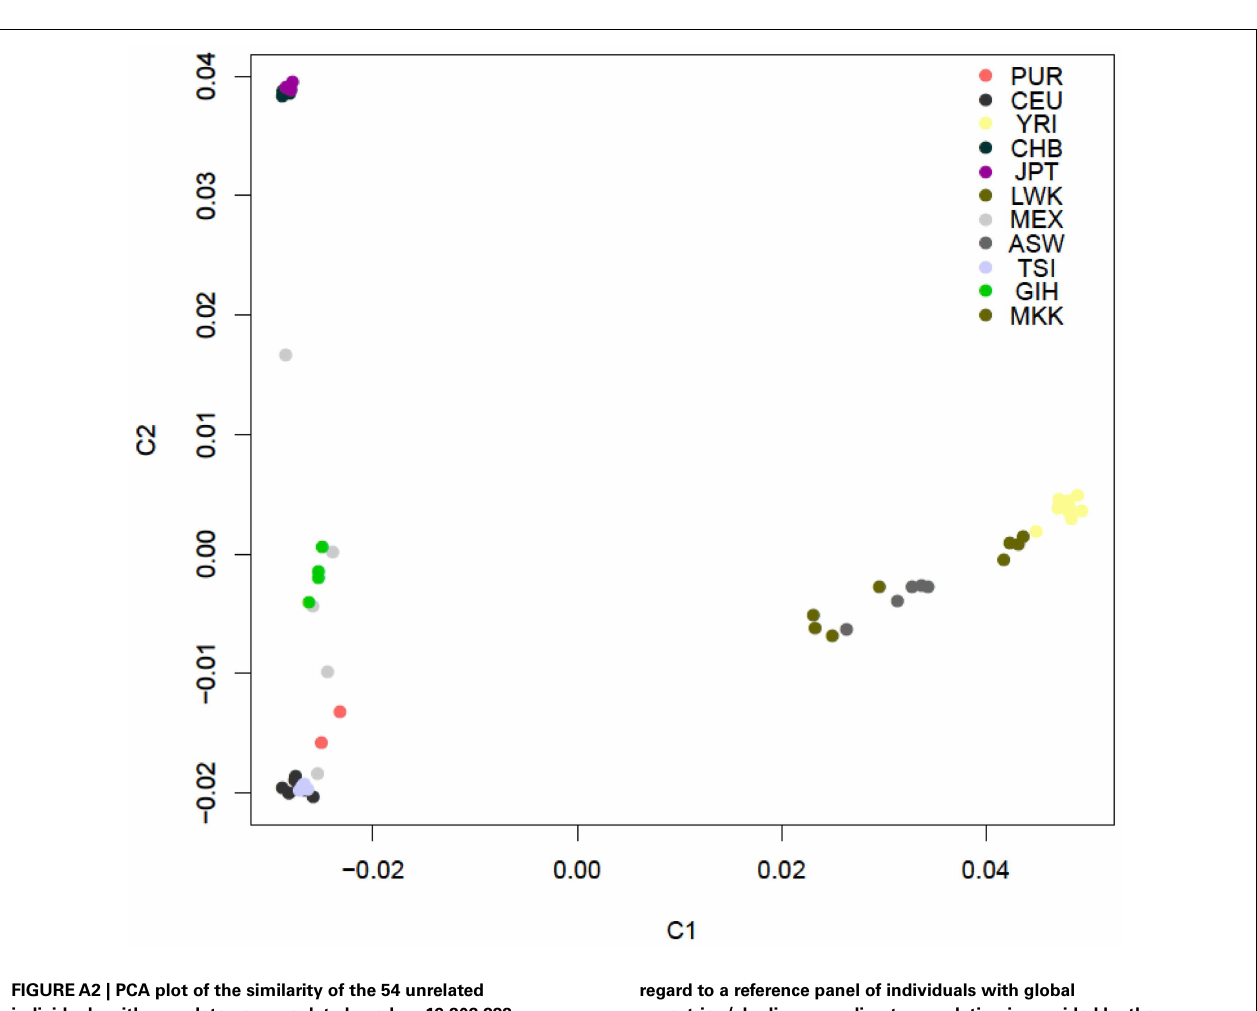
FIGUREA2 | PCA plot of the similarity of the 54 unrelated individuals with complete genome data based on 19,208,882 SNVs obtained from the complete sequencing data without